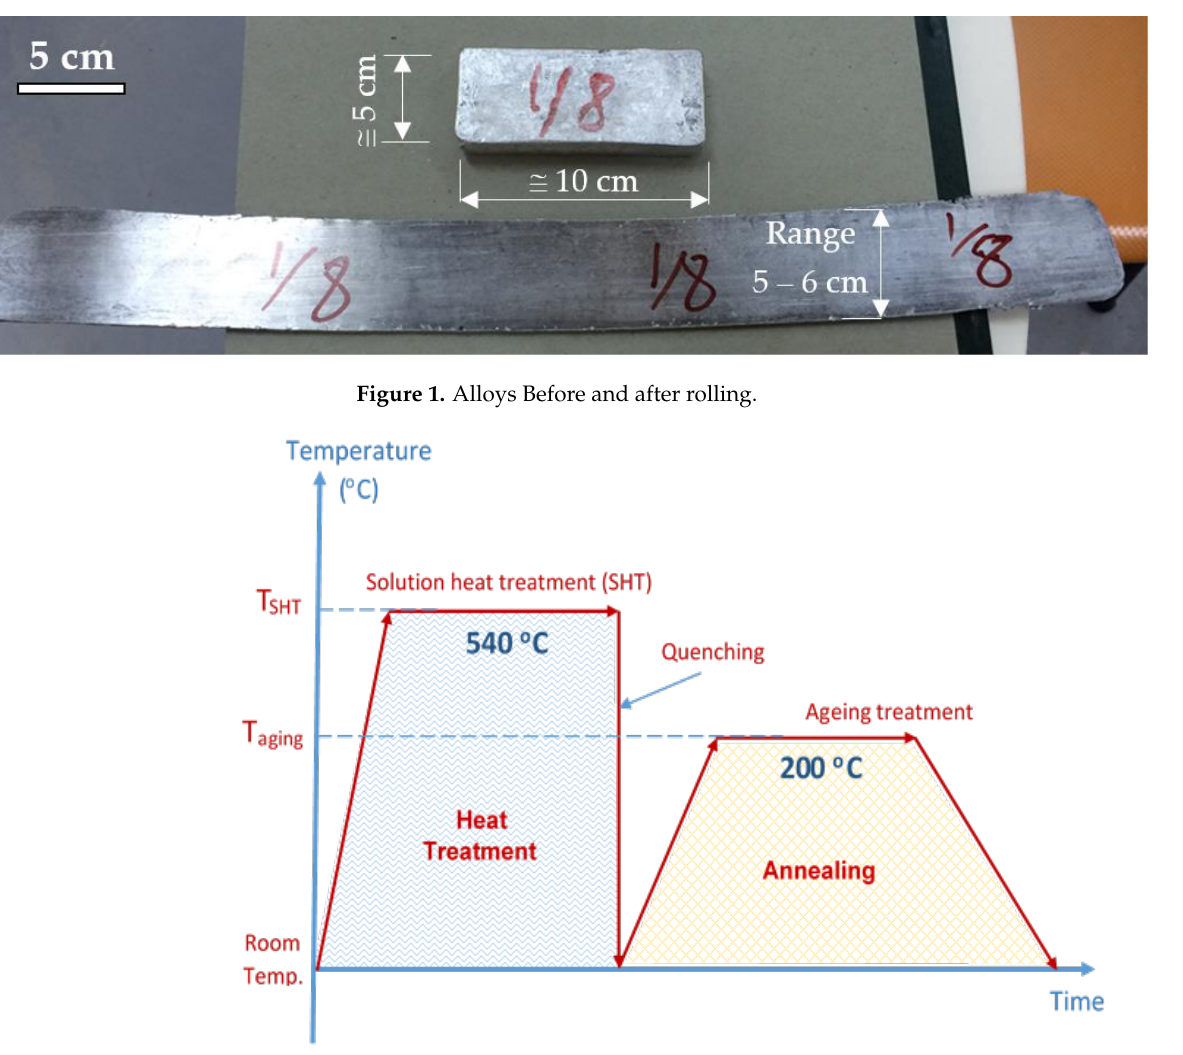
Figure 2. Schematic diagram for the heat treatment process